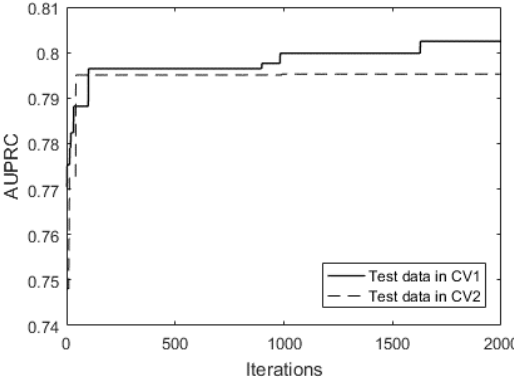
Figure 6. AUPRC of CV1 and CV2 over iterations. Table 2. Five different sets of AutoML